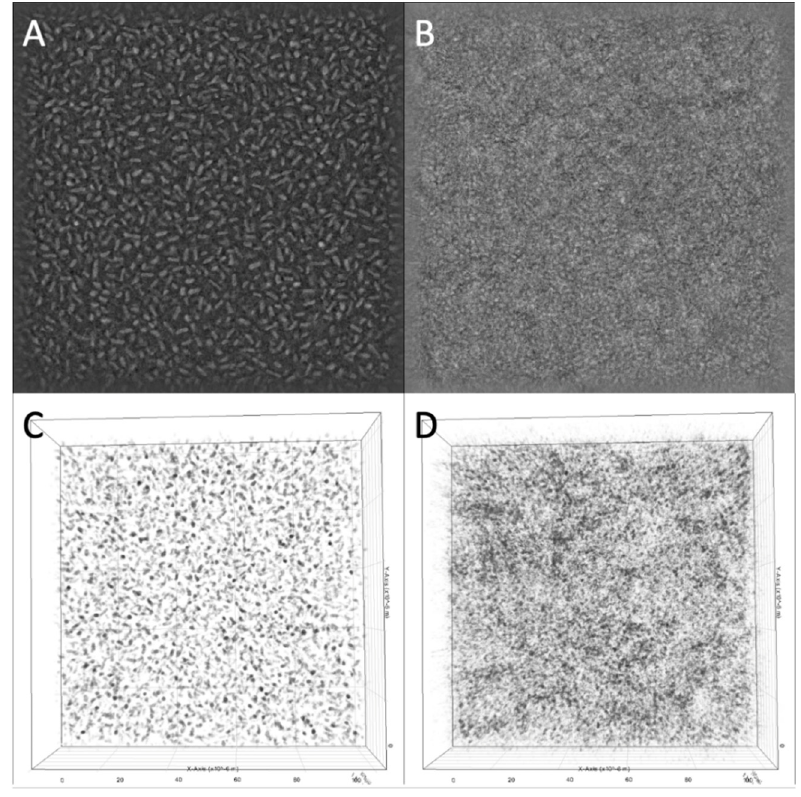
Figure 1. 3D Cell Explorer micrographs of K. pneumoniae (Kl 315) culture: ( A , C ) in the start; ( B , D ) after 1 h 40 min of incubation. Magnification ×58, the field of view size is 100 × 100 μ m. The experiment was conducted in one repetition.